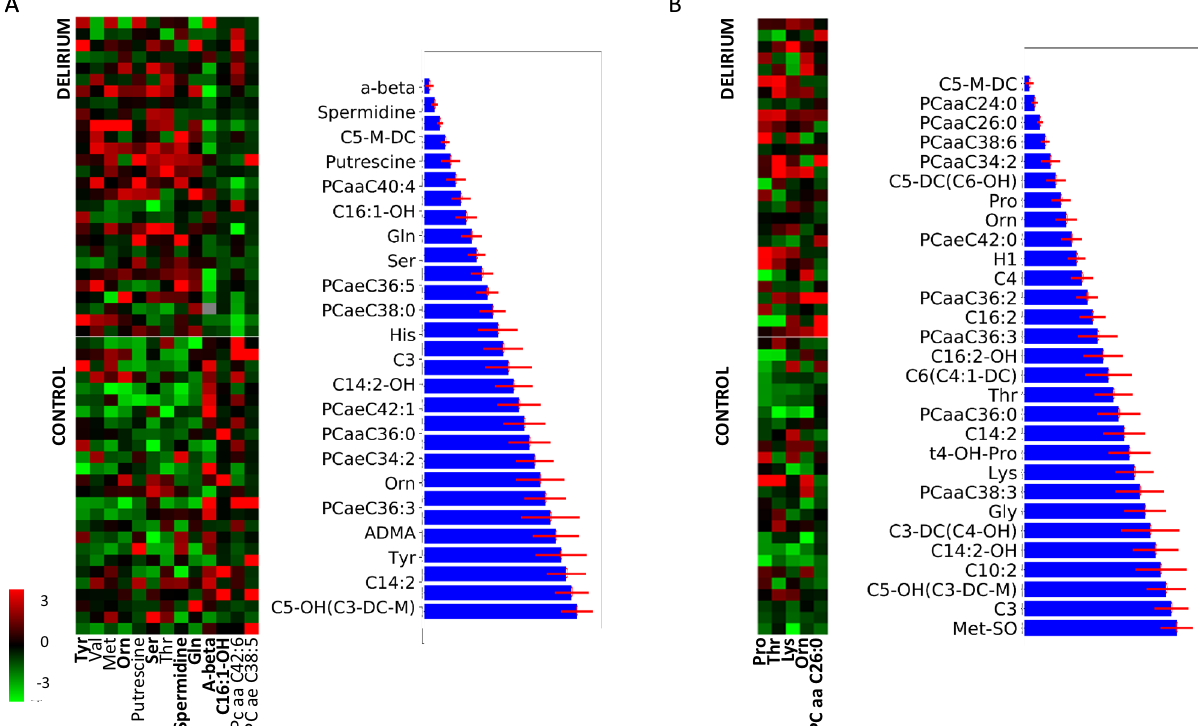
Figure 1. Most significant features distinguishing between control and delirium-prone cohort in ( A ) CSF and ( B ) Blood. SAM subset includes the most relevant metabolites based on statistical analysis (with delta value in TMeV implementation of SAM of 0.5) while the Random Forest method ranks metabolites’ relevance for diagnosis between two groups. Metabolic panel was selected from the Random Forest ranking Error bars shown in red represent uncertainties measure obtained using the probabilistic bootstrap method (see Materials and Methods for more 2-class Partial Least Squares-Discriminant Analysis (PLS-DA) were performed on CSF and blood metabolomic data samples. For both sample types PCA achieved only limited separation of control and delirium-prone cases (Supplementary Fig. 2A,B). Incorporation of patient gender had very minor improvement of PCA group sepa- ration (Supplementary Fig. 2E,F). Supervised PLS-DA identified combination of metabolite features capable of clearly distinguishing the two patient groups (Supplementary Fig. 2C,D). For the CSF data the output was closely aligned with the previously published analysis 13 . The importance of specific metabolites to the model’s discrimi- natory power are shown in coefficient plots (Supplementary Figs. 3–5). The most important contributors in control and delirium sample separation in CSF were spermidine, putrescine, glutamine (as previously reported by Pan et al. 13 ), but also 3-hydroxypalmitoleylcarnitine (C16-1-OH), linoleic acid (C18-2), carnitine (C0) and, to a lesser extent, a number of other metabolites (Supplementary Fig. 3 shown in red). For blood metabolomic data the discrimination of control and delirium patients was influenced most by levels of proline, ornithine, lysine, trans-4-hydroxyproline (t4-OH-Pro), PC aa C24:0 and PC aa C26:0 as well as H1, ADMA, C7-DC and, to a lesser extent, a number of other metabolites (shown in red in Supplementary Fig. 3 with the most significant metabolites selected using PLS-DA with c.v. and SAM showing in Supplementary Figs. 4 and 5). The above results were further corroborated by application of Statistical Analysis for Microarrays (SAM) 29 , which has been previously applied to metabolomics data 36 (Fig. 1A). SAM analysis of normalized CSF data found significant differences in CSF for ornithine, glutamine, putrescine, spermidine and threonine, similarly as previously shown 13 and in good agreement with the above PLS-DA (ornithine, glutamine, putrescine and spermidine were major features). Threonine was not one of the most significant contributors to the classifica- tion coefficients, but was still a significant contributor to the PLS-DA sample grouping. SAM analysis of blood metabolites shows major differences in pre-operative blood samples in proline, threonine, lysine, ornithine and phosphatidylcholines (specifically PC aa C26:0). Random forest (RF) is a supervised learning algorithm used here for the selection of significant metabolic features for classification between two patient groups. RF method builds an ensemble of decision trees that is in this application used to determine significance of each feature for the classification problem. Panel of the most diagnostically significant features is shown in Fig. 2. Selected panel of metabolites is shown together with the obtained classification rank and error in the rank based on the number of times the metabolite is listed with different rank in the repeated sampling process. Majority of SAM selected CSF metabolites and all metabolites selected in blood are also selected amongst the RF panel highest ranking group (shown in bold in Fig. 1).